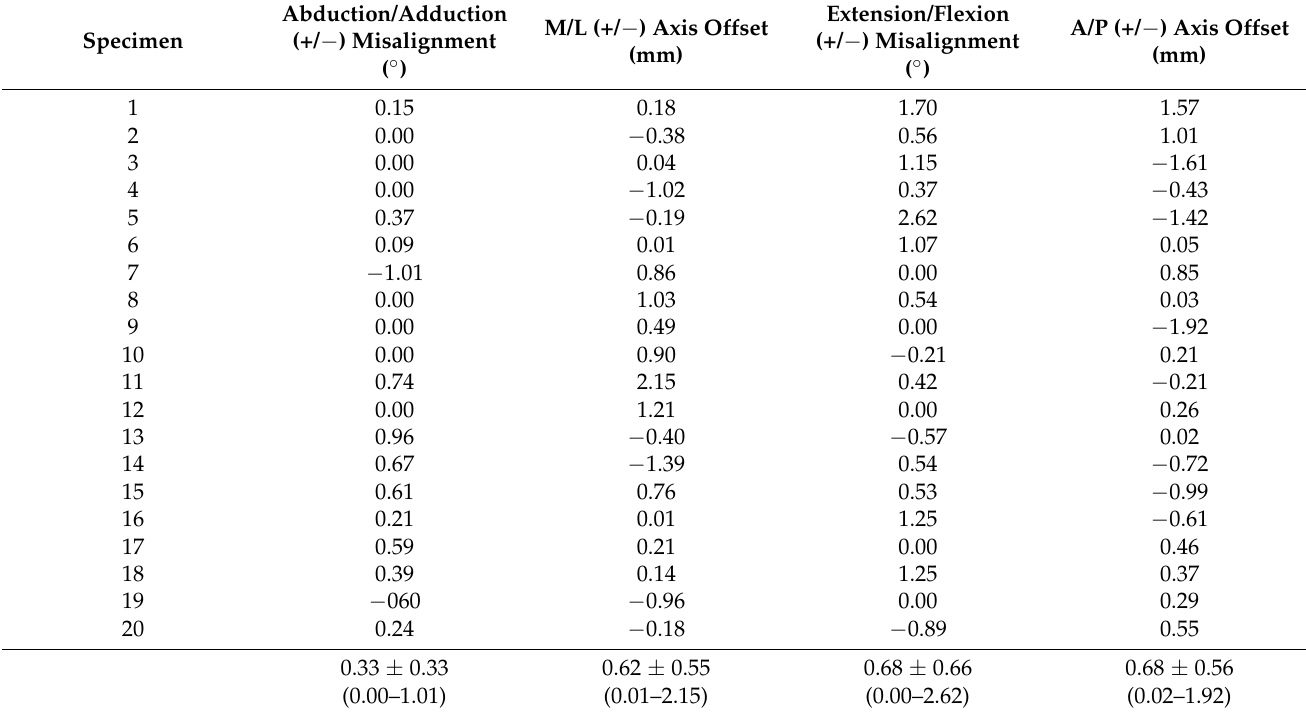
Table 2. Deviation data for the achieved fixture alignment presented as resulting hip abduction or adduction and extension or flexion and axis offset in the medial or lateral and anterior or posterior direction measured at the most distal axis point of the preoperatively planned fixture position for all specimens. Values for abduction, extension and axis offset into medial and anterior direction are expressed as positive (+) and their mirrored quantities as negative ( − ) values in relation to the preoperatively planned implant position. Means, standard deviations (SD), minima (MIN), and maxima (MAX) were calculated for the absolute values.